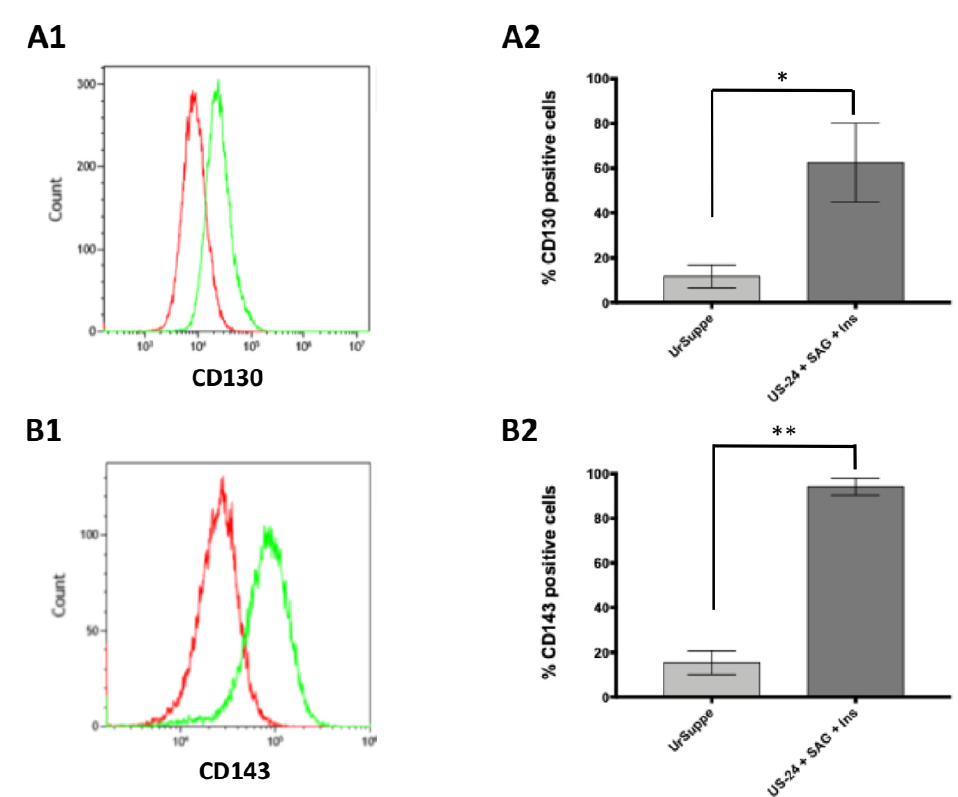
Figure 6. Analysis of CD130 and CD143 expression in hASCs. Cells were analyzed by flow cytometry for the expression of CD130 ( A1 , A2 ) and CD143 ( B1 , B2 ). ( A1 , B1 ) Exemplary mono-parametric histograms showing the expression of CD130 or CD143 in hASCs grown in UrSuppe or US-24 with SAG and Insulin medium: Red line: hASCs grown in UrSuppe medium stained with anti- CD130-APC or anti-CD143-PE (control samples). Green line: hASCs induced with US-24 with SAG and Insulin medium and stained with anti-CD130-APC or anti-CD143-PE (test samples). ( A2 , B2 ) Quantification of flow cytometry analysis, percentage of CD130 or CD143 positive cells in UrSuppe, or US-24 with SAG and Insulin medium ( n = 3, error bars represents S.E.M., p value; *: p value < 0.05; **: p value <